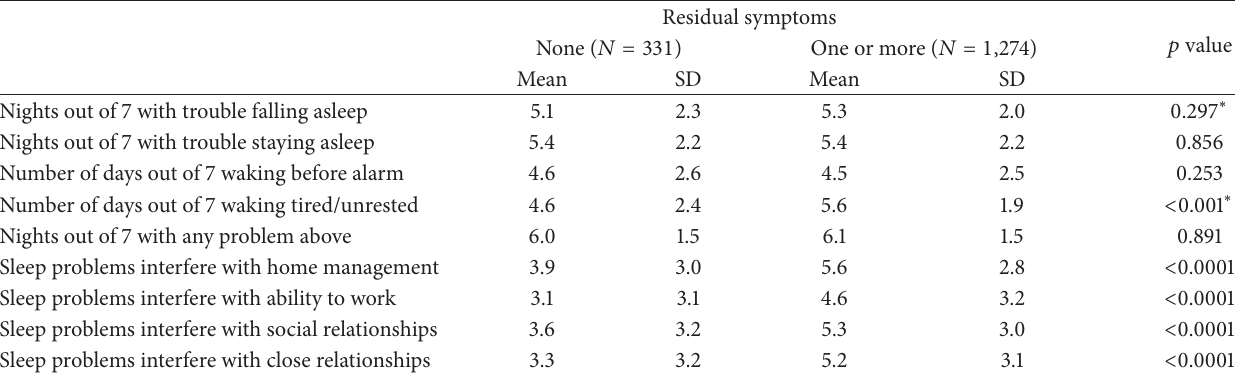
Table 3: Sleep-related trouble according to the presence of residual